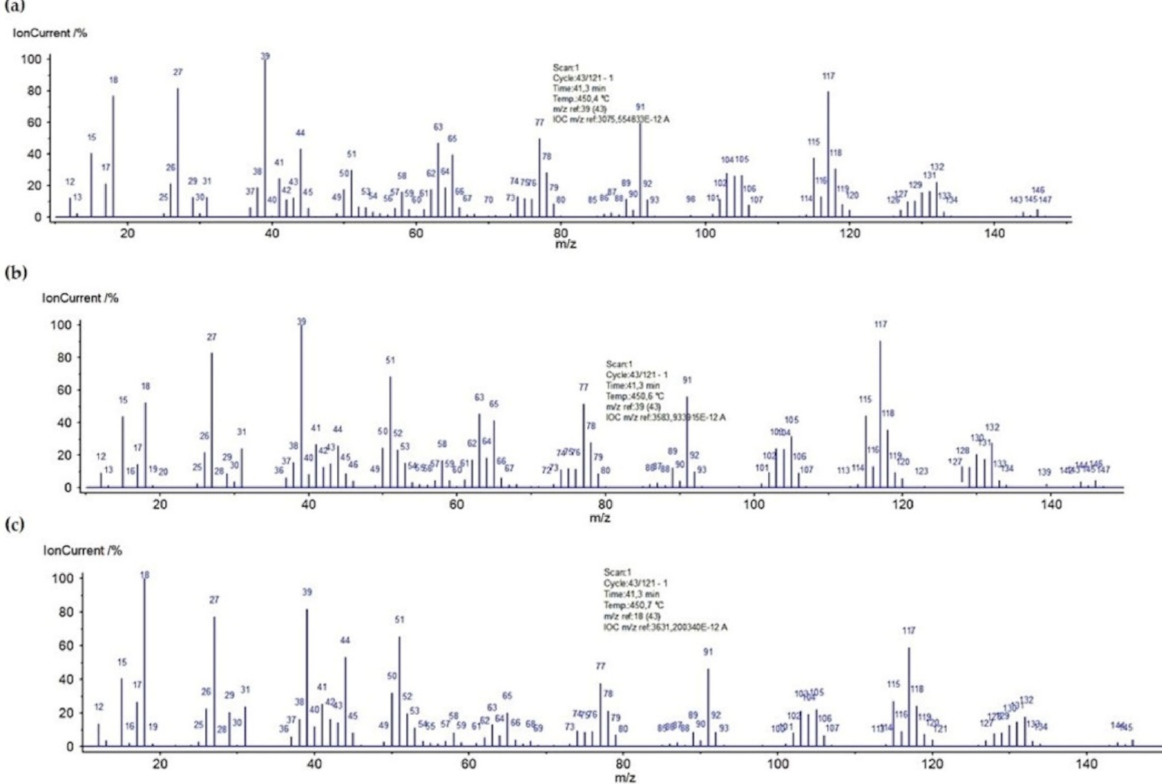
Figure 16. MS profiles registered during decomposition of DVB:TEVS = 1:1 after adsorption of P ( a ), 4-NP ( b ) and NB ( c